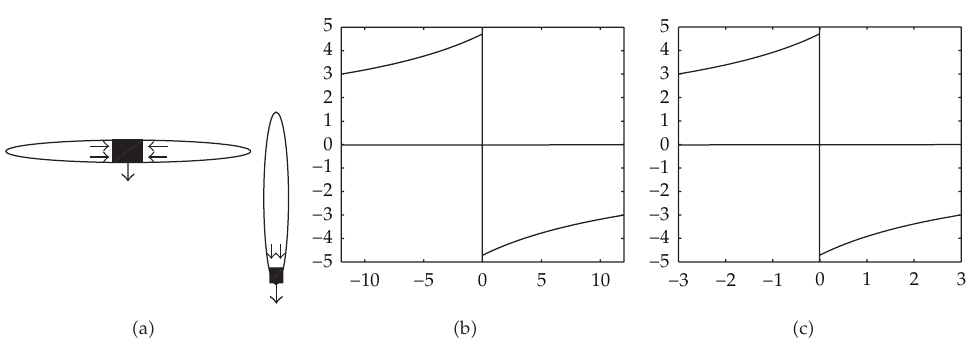
Figure 4: (cid:5) a (cid:6) Thin horizontal (cid:5) left (cid:6) and thin vertical (cid:5) right (cid:6) elliptical vessels. The sphincter region in black is shown. Incoming flows induced outside that region are also shown. (cid:5) b, c (cid:6) Plot of the velocity u (cid:5) vertical axis (cid:6) against x (cid:5) horizontal axis (cid:6) at time t (cid:9) 0 (cid:5) b (cid:6) for initial conditions a (cid:9) 12 , b (cid:9) 4 (cid:5) implies a (cid:3) (cid:9) − 3 , b (cid:3) (cid:9) − 1 (cid:6) , and at time t (cid:9) 3 (cid:5) c (cid:6) . They look similar but on di ff erent